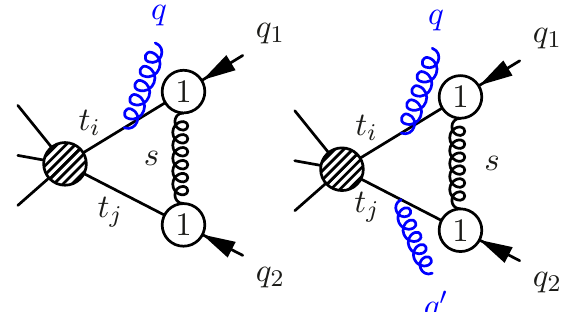
(cid:16) (cid:17) (cid:16) (cid:17) J T 1 J T 1 (cid:31);(cid:24) (cid:31);(cid:24) i j !